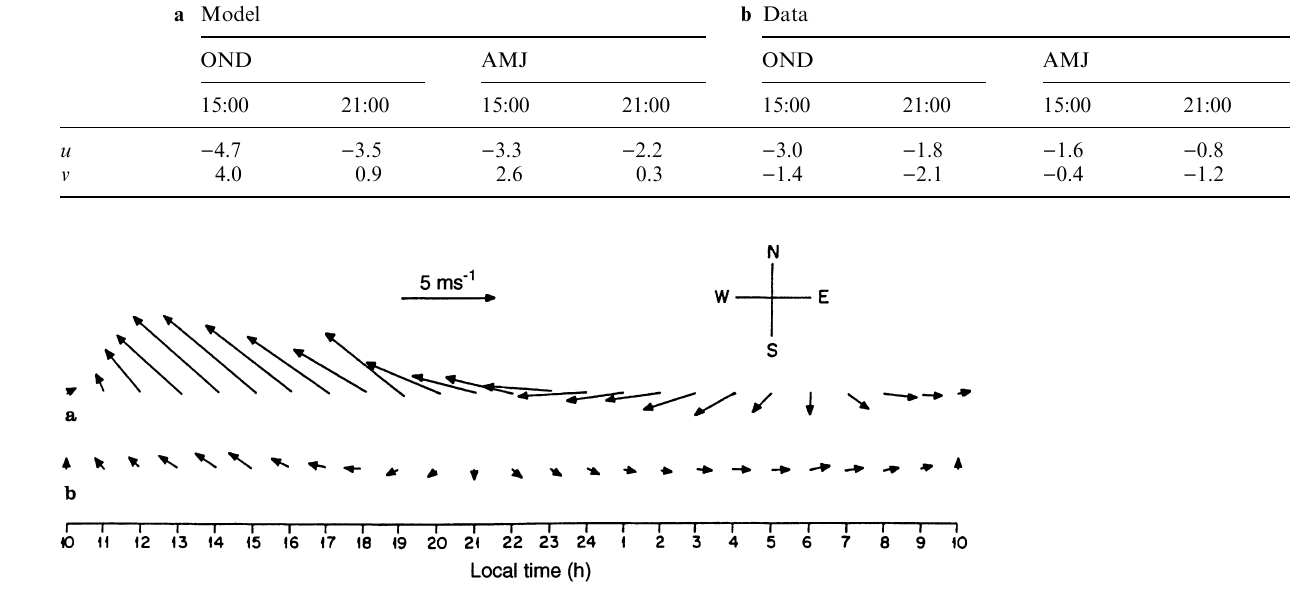
surface) near coast for OND (10 y means, 1971–1980) obtained from the Meteorological Station in Cabo Frio (point F in Fig. 1). Units are m s (cid:255) 1